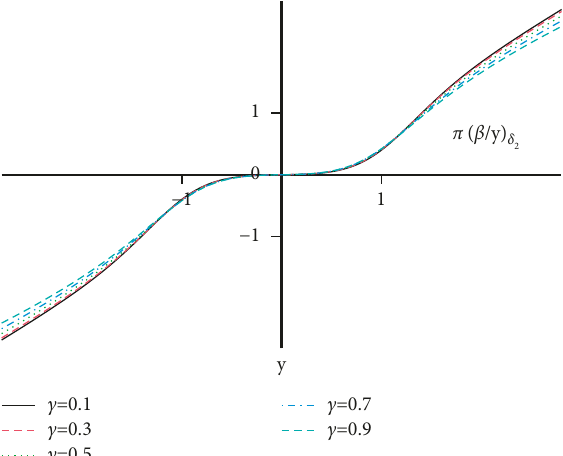
Figure 8: Plots the rule Π ( β and; ζ � 0 . 6, μ � 9 and c � 0 .